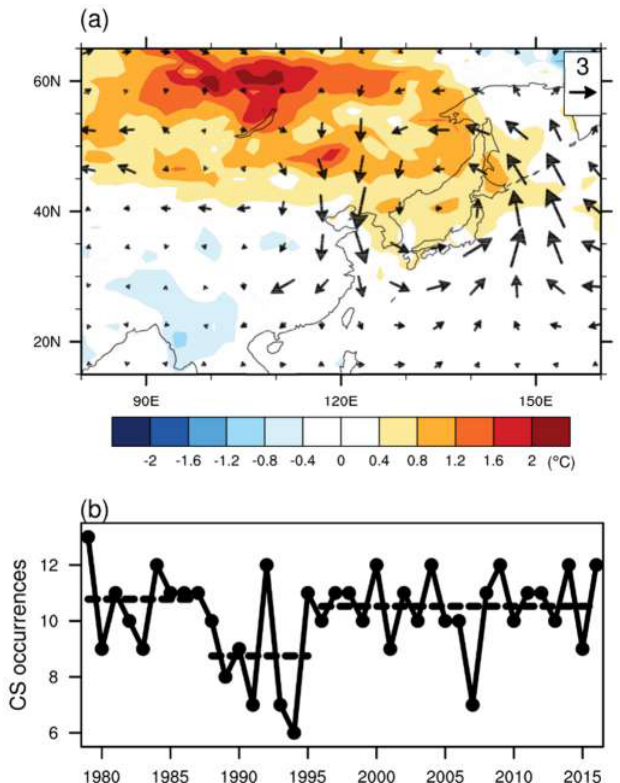
Figure 7. ( a ) SAT anomalies (°C) during 1988–1994 from climatology in winter season and composite of daily wind anomalies at 850 hPa for cold surge occurrence dates, ( b ) time series of the number of winter cold surge occurrences. The dashed lines show the mean number of cold surge occurrences during 1979–1987, 1988–1994, and 1995–2016.